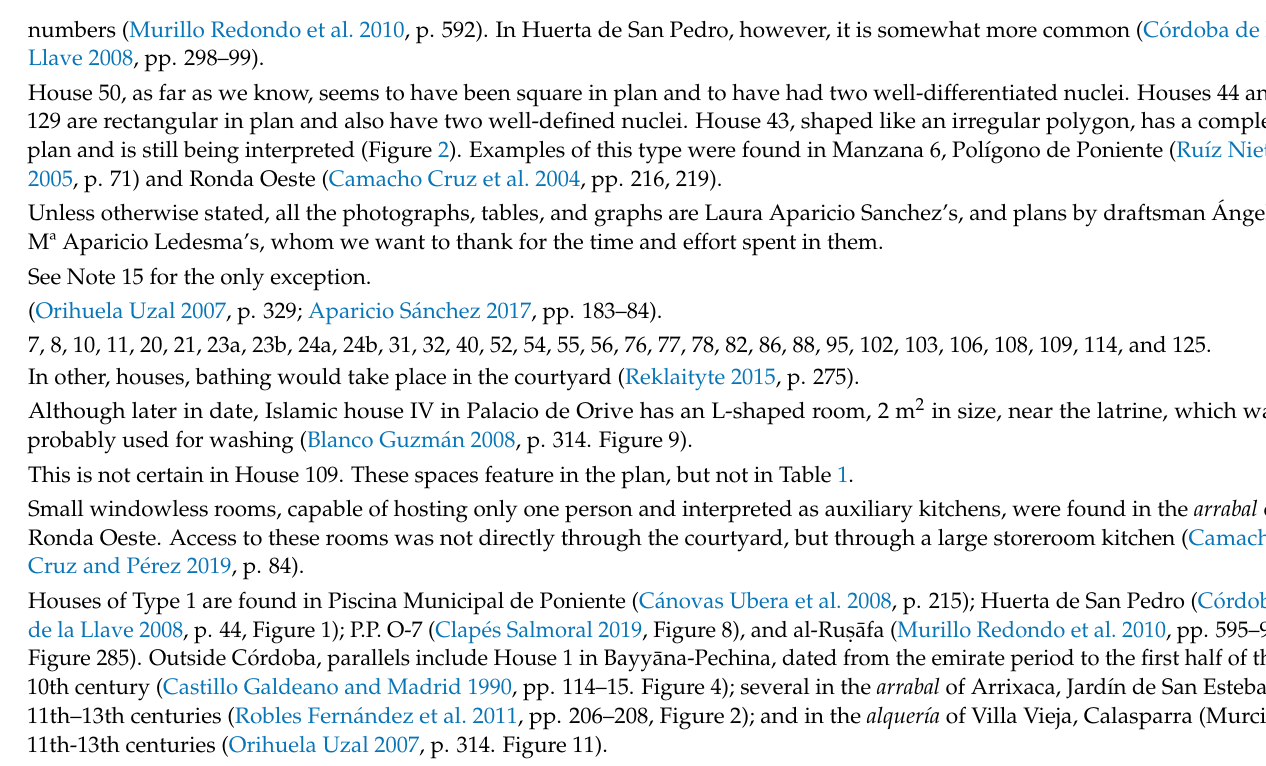
Figure 286); and Ronda Oeste (Camacho Cruz and P é rez 2019, p. 65). It is also found in considerable numbers in the arrabal of El Fort í , Denia, where it is known as Type I. These are dated to the 12th and early 13th centuries (Sent í Ribes et al. 1993, p. 277, Figure 2.1; Gisbert Santonja 2011, p. 103–6). House 4 in Bayy¯ana-Pechina, uses this space as a living room (Castillo Galdeano